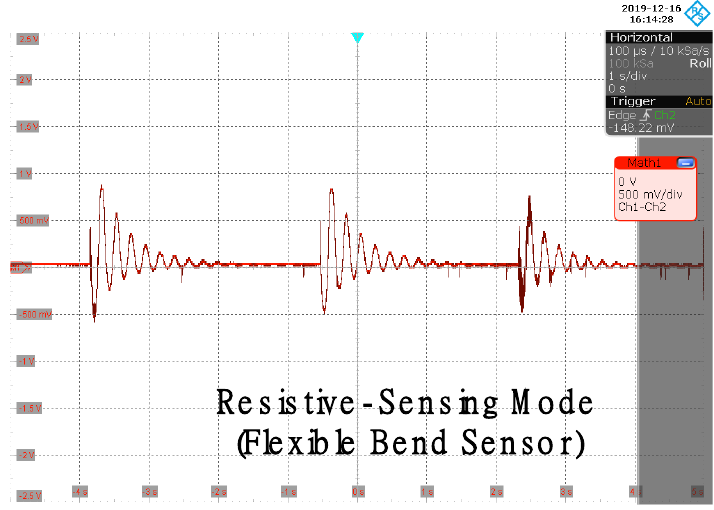
Figure 17. The real-time measurement result using a flexible bend sensor.